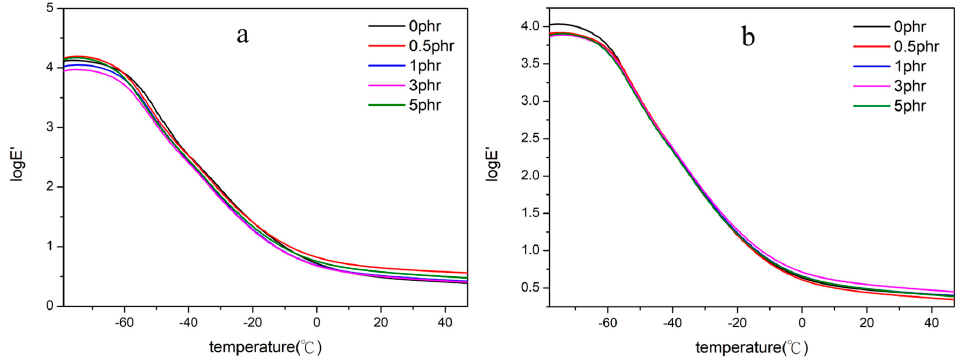
Figure 10. Storage modulus measurements: ( a ) MoS 2 -ethanethiol-butyl and ( b ) MoS 2 -nonanethiol- butyl rubber.